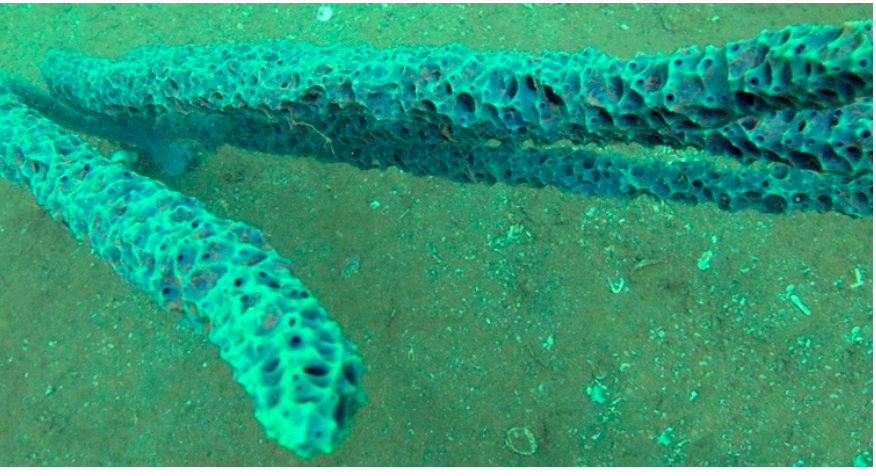
Figure 3. Specimens of Dendrilla lacunosa demosponge [38].